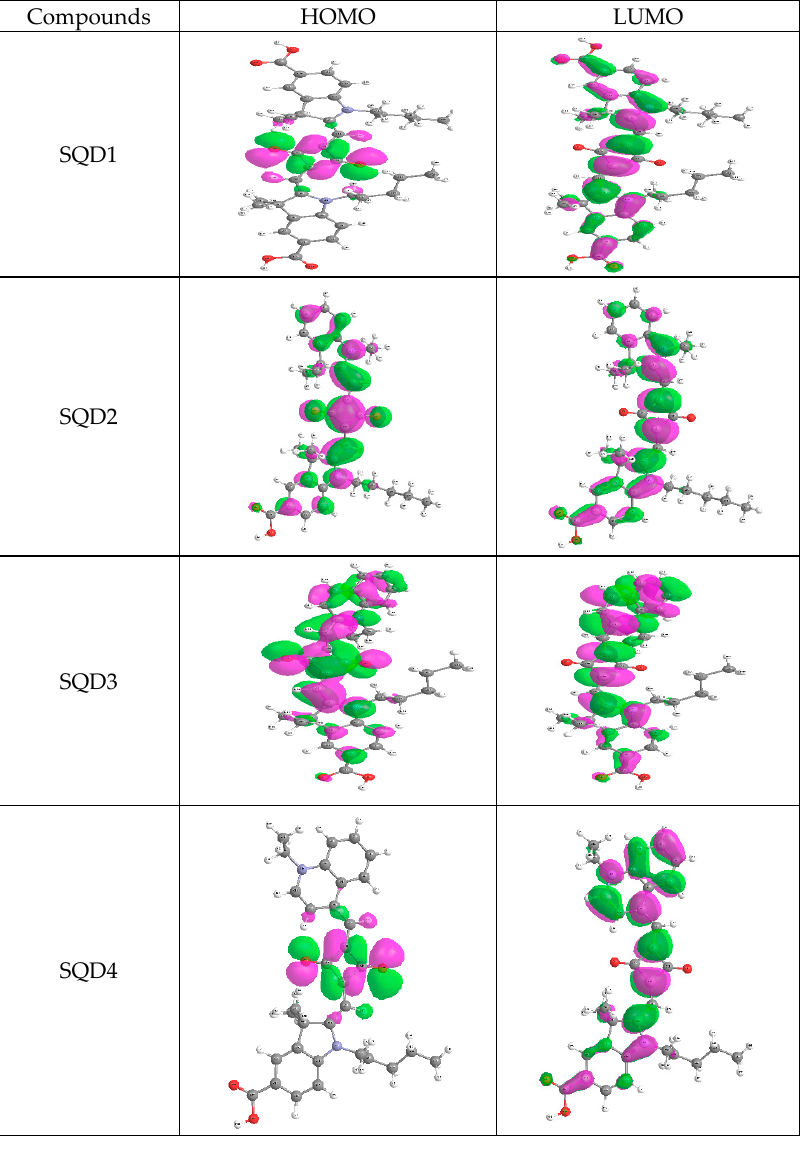
Figure 4. Schematic diagram of natural transition orbitals (NTOs) of the studied dyes calculated at the PBE/6-311++G** level of theory. The surfaces are generated with an isovalue at 0.02.